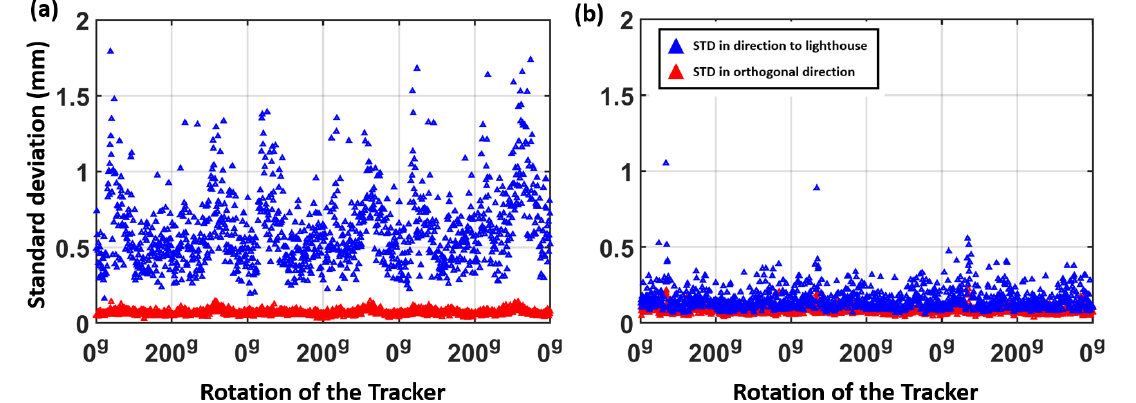
Figure 18. Investigation of the noise pattern at each rotation step in a setup ( a ) with one lighthouse and ( b ) with two lighthouses.